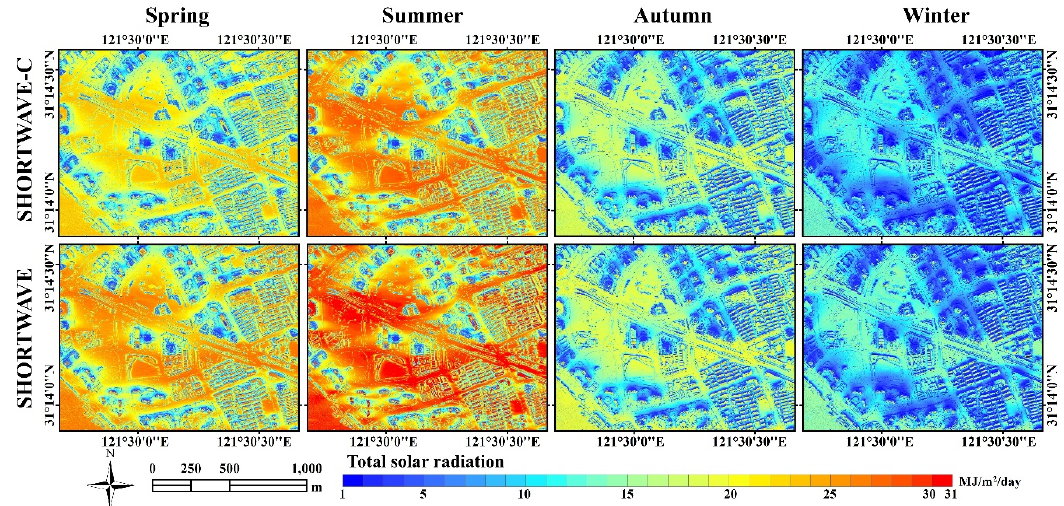
Figure 4. Seasonal average total solar radiation distribution estimated by SHORTWAVE-C model and SHORTWAVE model in the Lujiazui region.